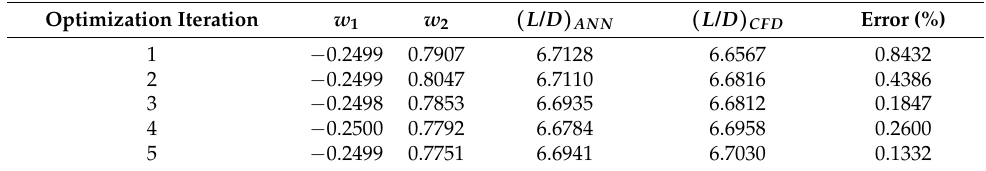
Table 3. Evolution of the optimization results during the optimization loop. The “error” in the last row shows the percentage difference between the ANN-computed and CFD-computed lift-to-drag ratios compared with the latter